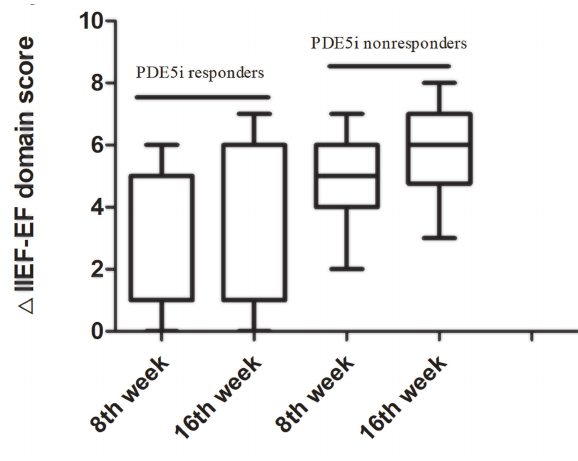
Figure 2 - △ A change from baseline. PDE5i nonresponders will have PDE5i before assessment both in 8 th and 16 th week, but PDE5i responders not.